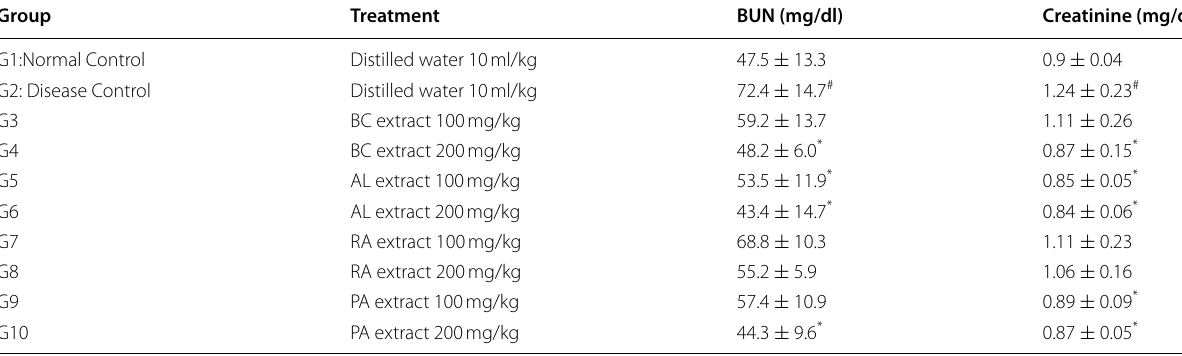
#: p < 0.05 when compared to G1 Normal Control; *: p < 0.05 when compared to G2, Disease control